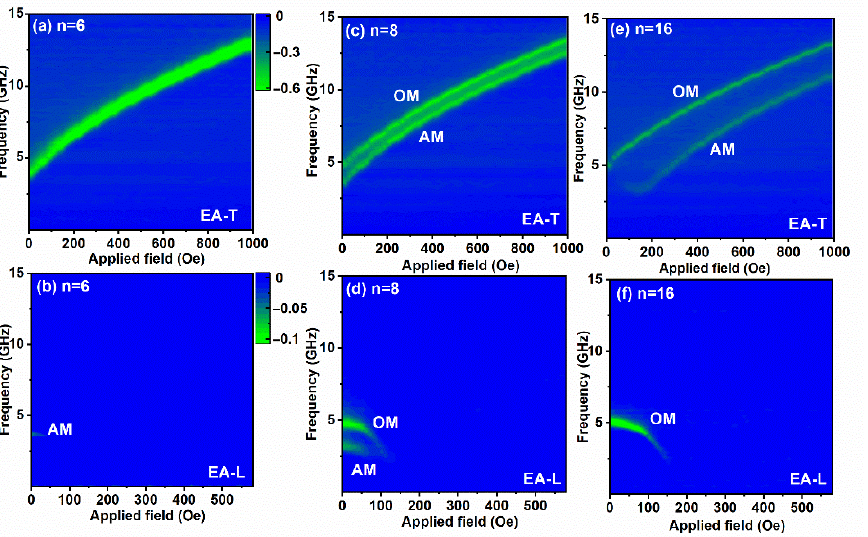
Figure 5. The 2D contour projection diagrams ( S 21 – H curves) for typical samples with n = 6 ( a , b ), 8 ( c , d ), and 16 ( e , f ) measured at T- and L-modes along EA direction.